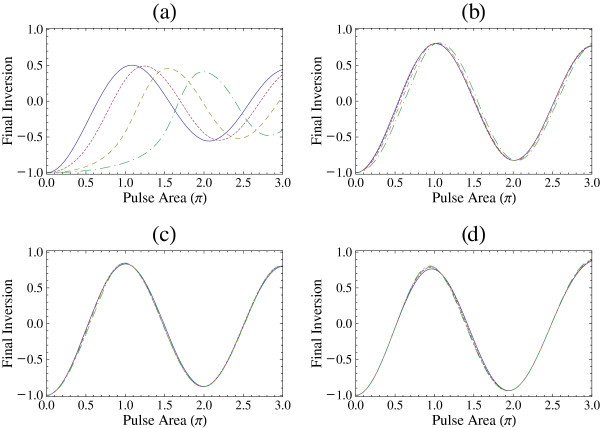
Final inversion S3(2tp) for sin-squared pulse as a function of pulse area θ. The pulse area is in multiples of Π. The excitation is on-resonance and φ = 0. (a) np= 10, (b) np= 3, (c) np= 2, and (d) np= 1. Solid curve: N = 109cm−2, dotted curve: N = 3 × 1011cm−2, dashed curve: N = 5 × 1011cm−2, and dot-dashed curve: N = 7 × 1011cm−2.